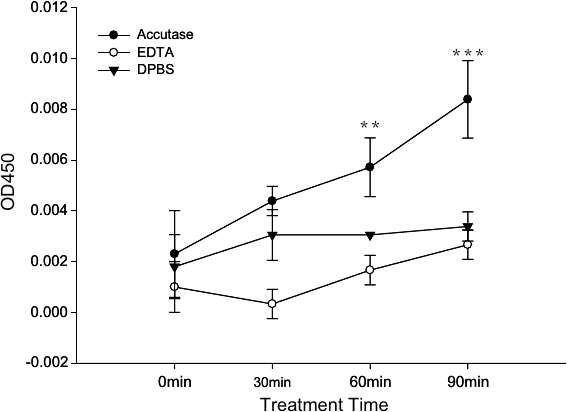
Figure 4. The proliferation of cells treated with different detachment buffers was detected by the CCK-8 assay. RAW264.7 macrophage proliferation was significantly increased by treatment with accutase for 30, 60 (p < 0.01) and 90 min (p < 0.001); *compared with EDTA detachment buffer and